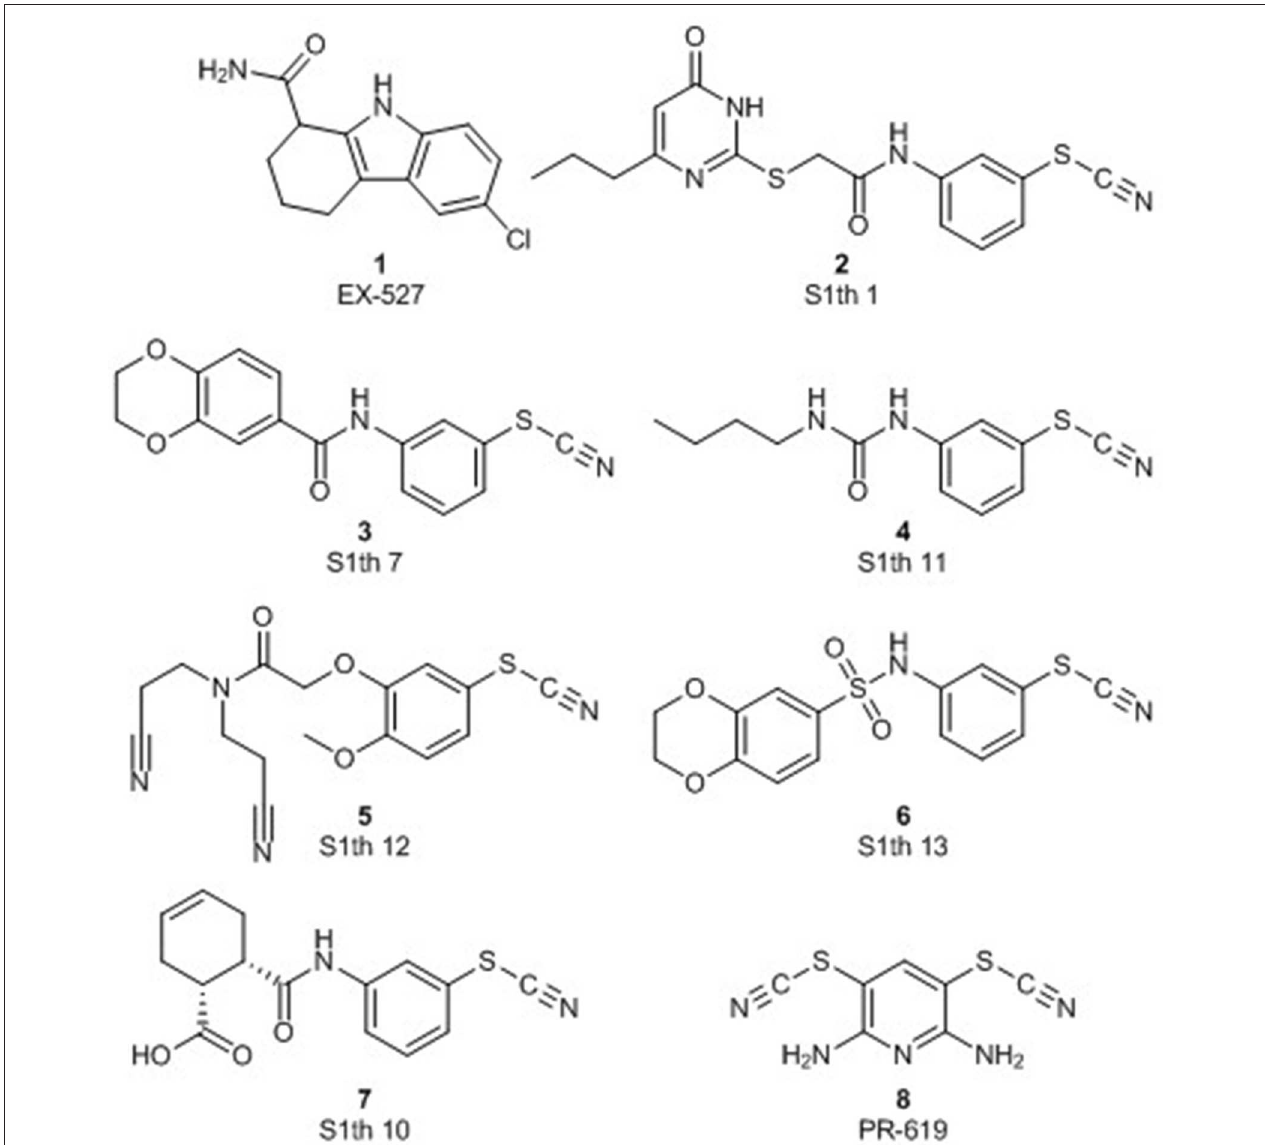
FIGURE 1 | Structures of S1th 1 , 7 , S1th 10–13 , the pan-DUB inhibitor PR-619 and the reference Sirt1 inhibitor EX-527 .